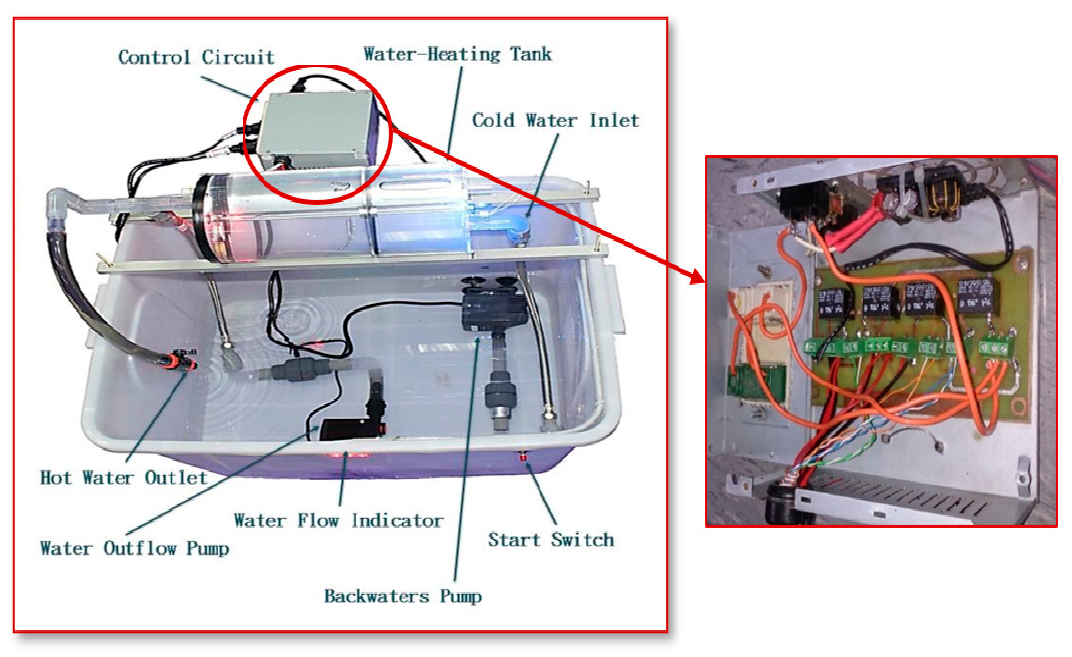
Figure 9. The validation prototype of this work.